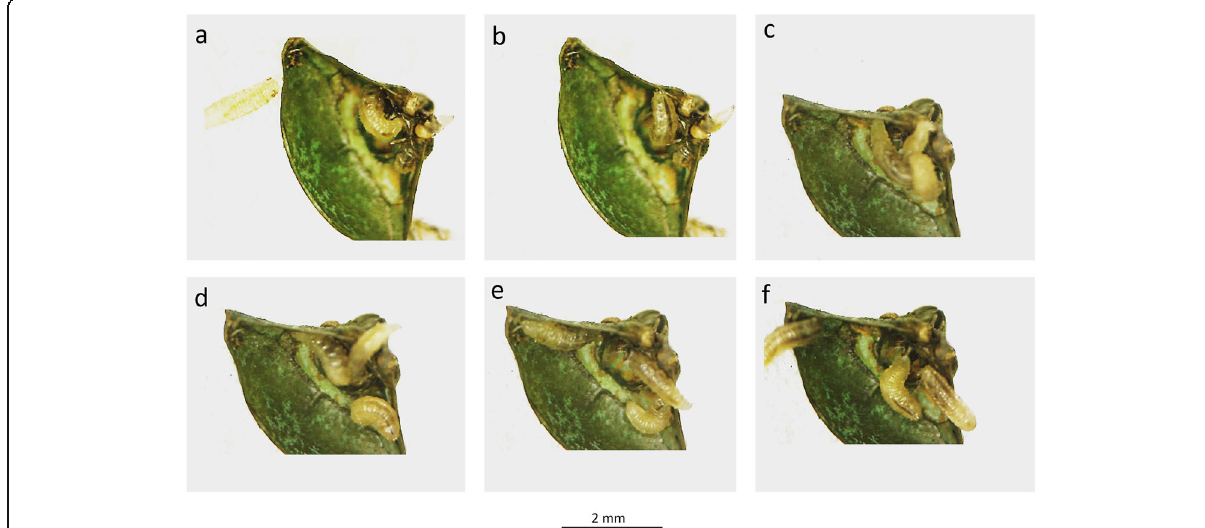
Fig. 2 a – f emergence of third larval instar of Megaselia scalaris from head of Nezara viridula (L.) for pupation